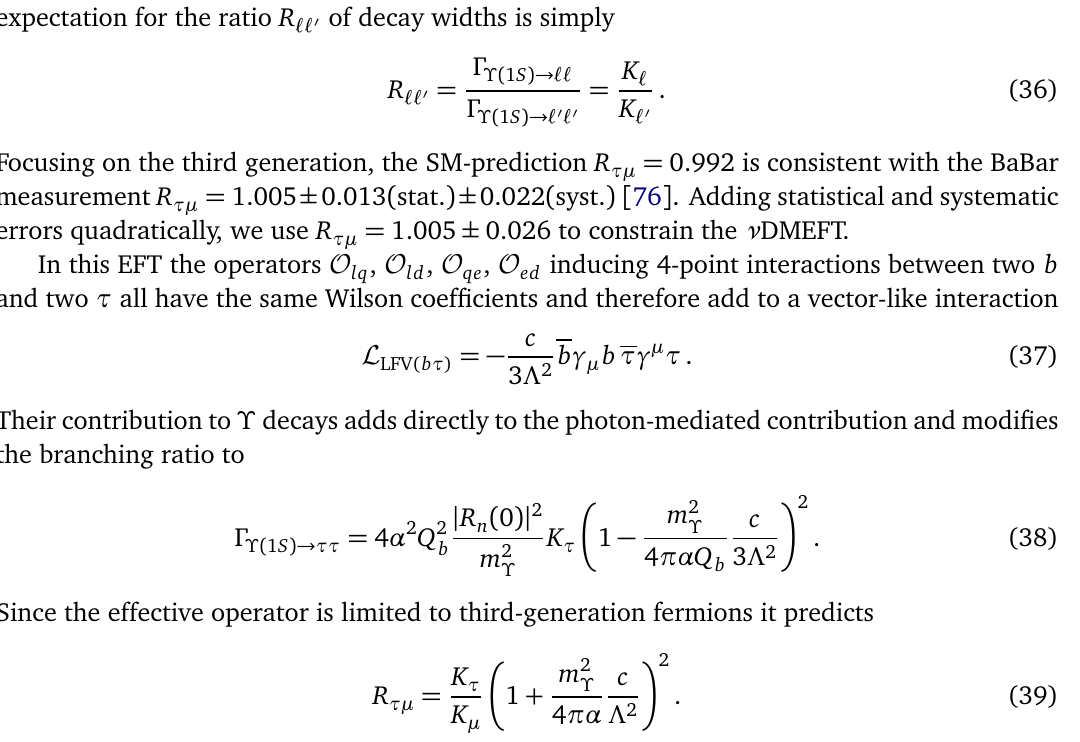
( 5 ) . The bounds NH O